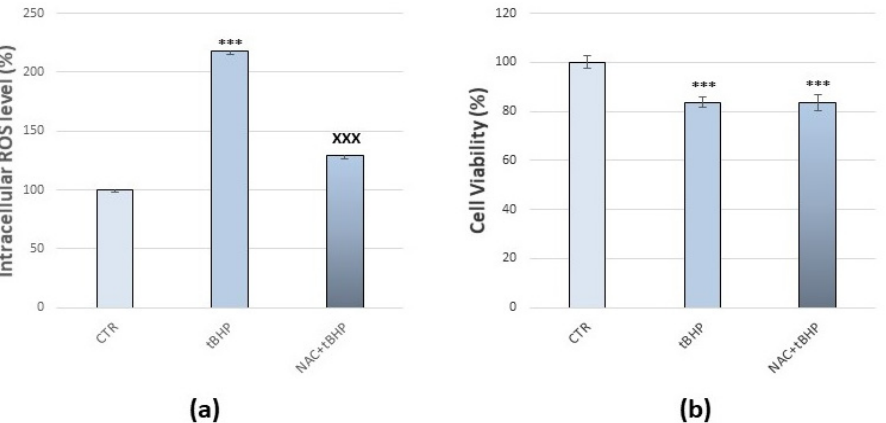
Figure 2. Effects of NAC against tBHP mediated oxidative stress in C6 glioma cells. ( a ) Intracellular DCF fluorescence intensity of cells treated with 50 µ M tBHP for 30 min with and without pre-treatment with 5 mM NAC for 24 h. ( b ) Cell viability of cells treated with 50 µ M tBHP for 30 min with and without pre-treatment with 5 mM NAC for 24 h. Values represent mean ± SE obtained from three independent experiments. *** p < 0.001 versus control, XXX p < 0.001 versus tBHP.